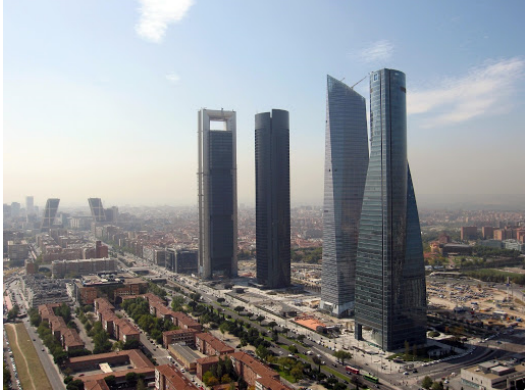
Figure 2. View of Cuatro Torres from the northern Paseo de la Castellana [34]. Copyright 2008